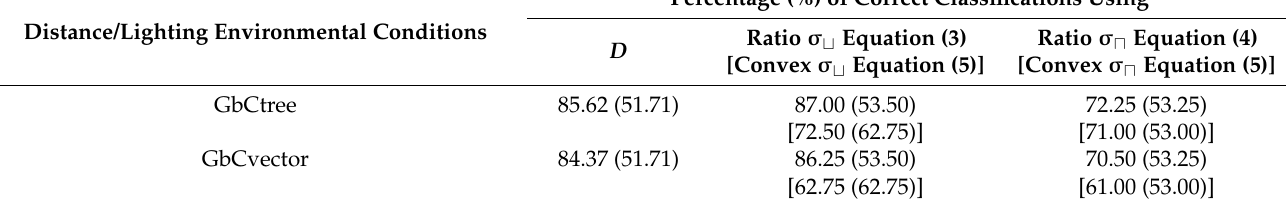
Table 9. Results by GbC classifiers both optimized and non-optimized (within parentheses) for linear positive valuation function regarding face recognition.